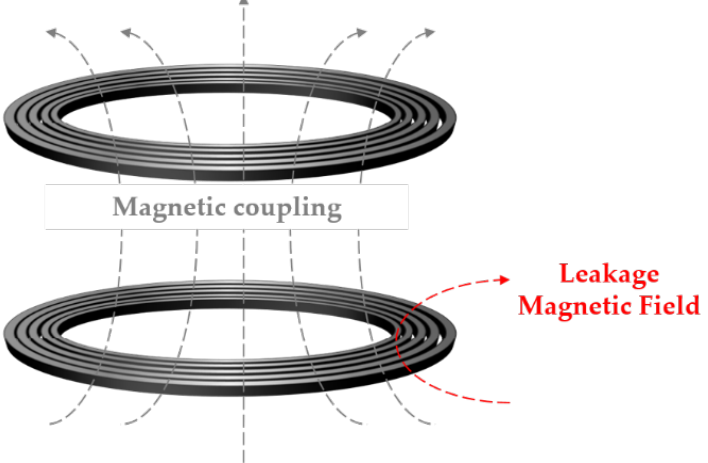
Figure 1. Coupled and leakage magnetic field in the process of transferring power wirelessly.